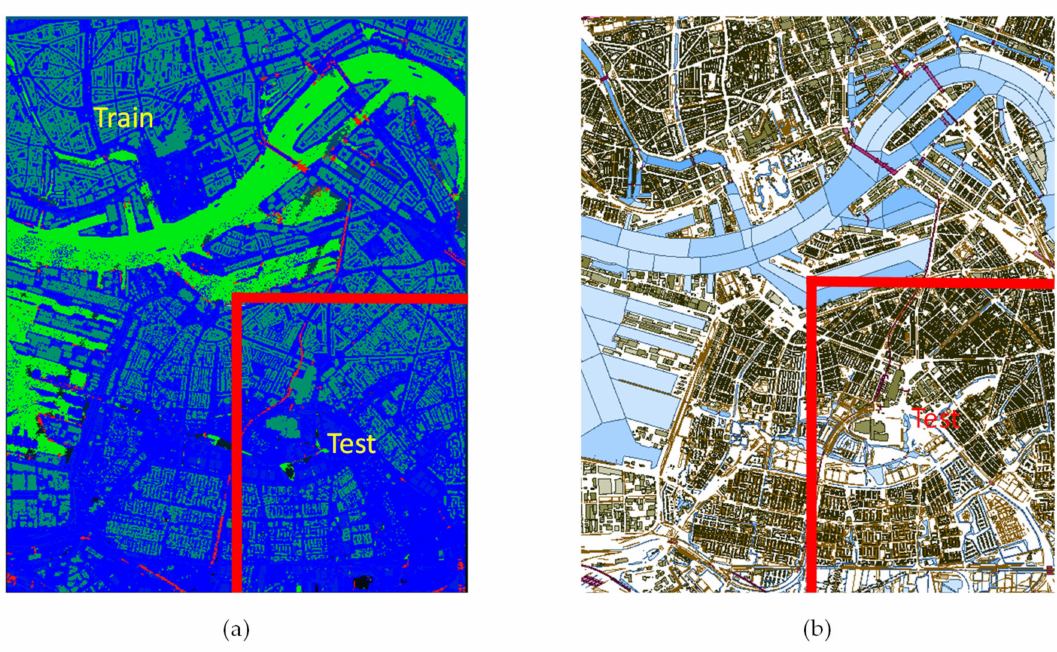
Figure 6. Experiment data in Rotterdam city. ( a ) AHN3 point clouds data; ( b ) Four classes derived from the BGT topographic map (polygons from the testing area are not used in the prediction work).